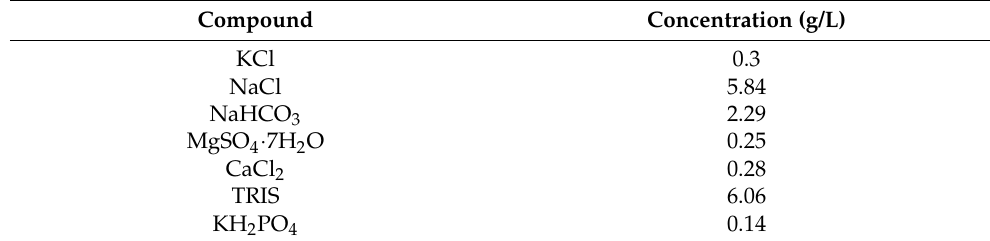
Table 1. Composition of SBF used in corrosion